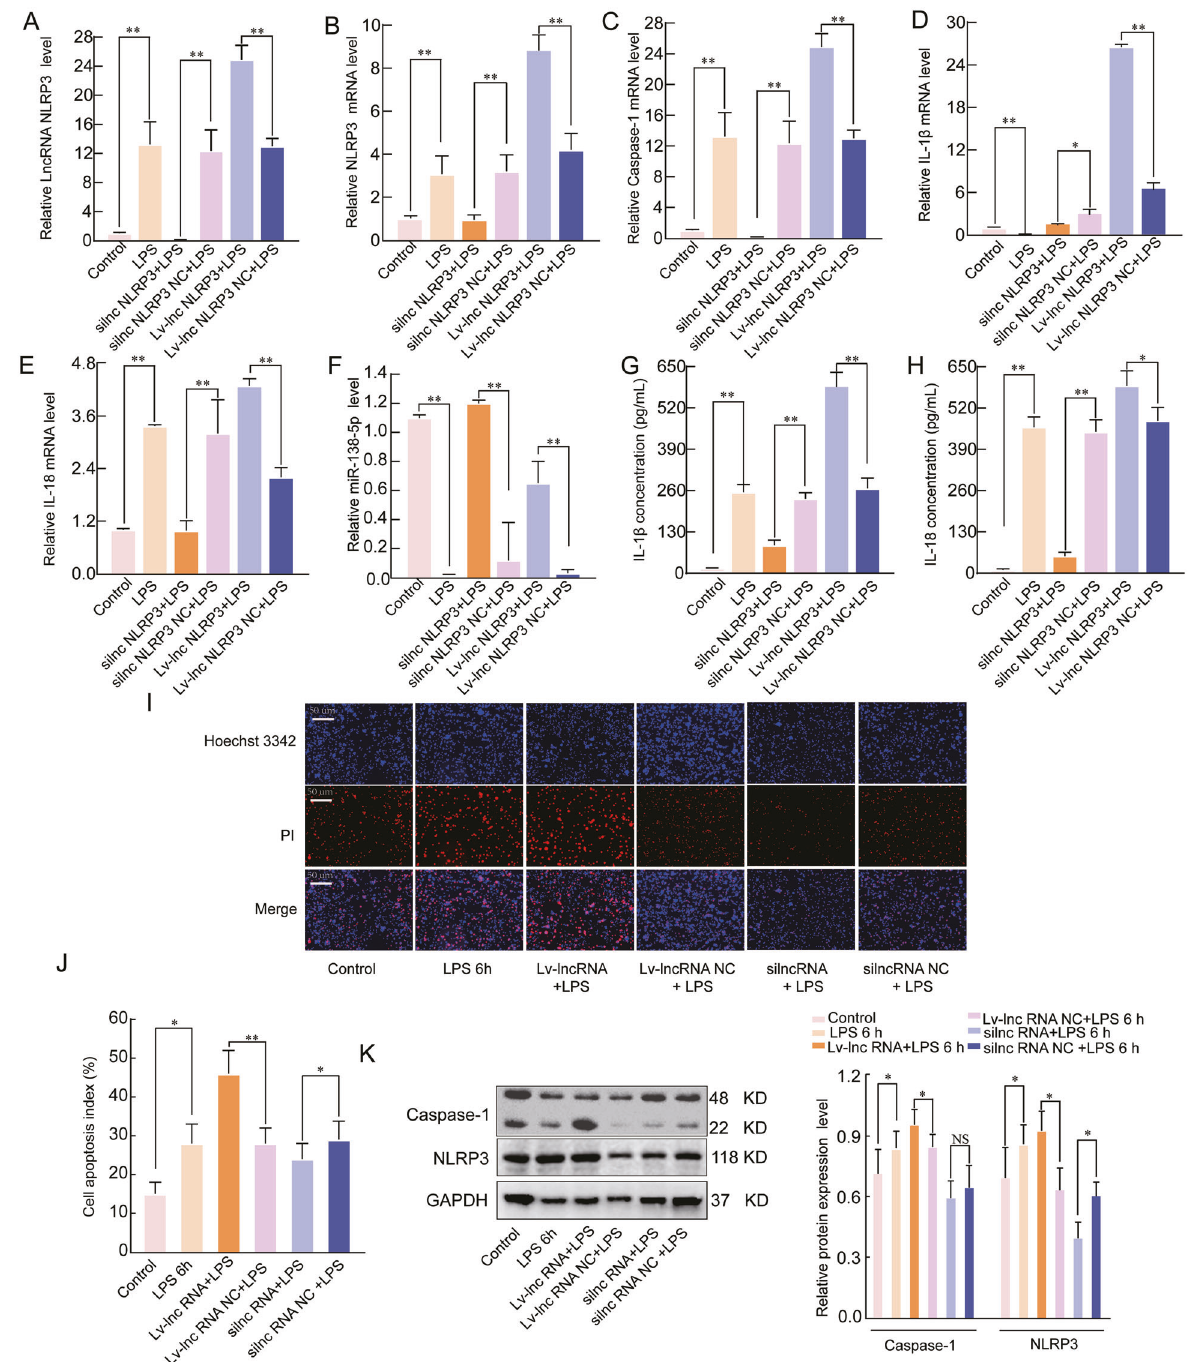
Fig. 3 LncRNA NLRP3 regulates the in fl ammatory response during ALI through NLRP3 in fl ammasomes. A qRT-PCR assay was used to analyse the mRNA expression of A lncRNA NLRP3, B NLRP3, C Caspase-1, D IL-18, E IL-1 β , and F miR-138-5p in LPS -induced ALI. β -Actin was used as the reference gene. G , H ELISA was used to analyse the IL-1 β and IL-18 levels in the culture supernatants. I , J Cell apoptosis was determined by Hoechst 33342 and PI dual staining assays ( I ) and counted ( J ). K Western blotting was used to analyse the protein expression of NLRP3 and caspase-1 after lncRNA NLRP3 overexpression in the cytoplasm. The data are presented as mean ± SE ( n = 6). * P < 0.05; ** P < 0.01; *** P < 0.001; NS, no statistically signi fi cant histopathological changes associated with LPS-induced ALI ( P < 0.05, the lungs, such as neutrophil in fi ltration, pulmonary oedema, alveolar Fig. 7A, B). Compared with those in the NC group (PBS), the BALF wall thickening, and alveolar haemorrhage, were observed in each albumin levels, W/D, and MPO were decreased in the si-r-lncRNA group after the LPS challenge. The degree of each characteristic was NLRP3-treated group ( P < 0.05, Fig. 7C – E). Moreover, the expression of scored as 3 (prominent), 2 (moderate), 1 (mild), and 0 (absence). NLRP3 was analysed in the lung tissues from rats by IHC and IF However, si-r-lncRNA NLRP3 administration ameliorated the